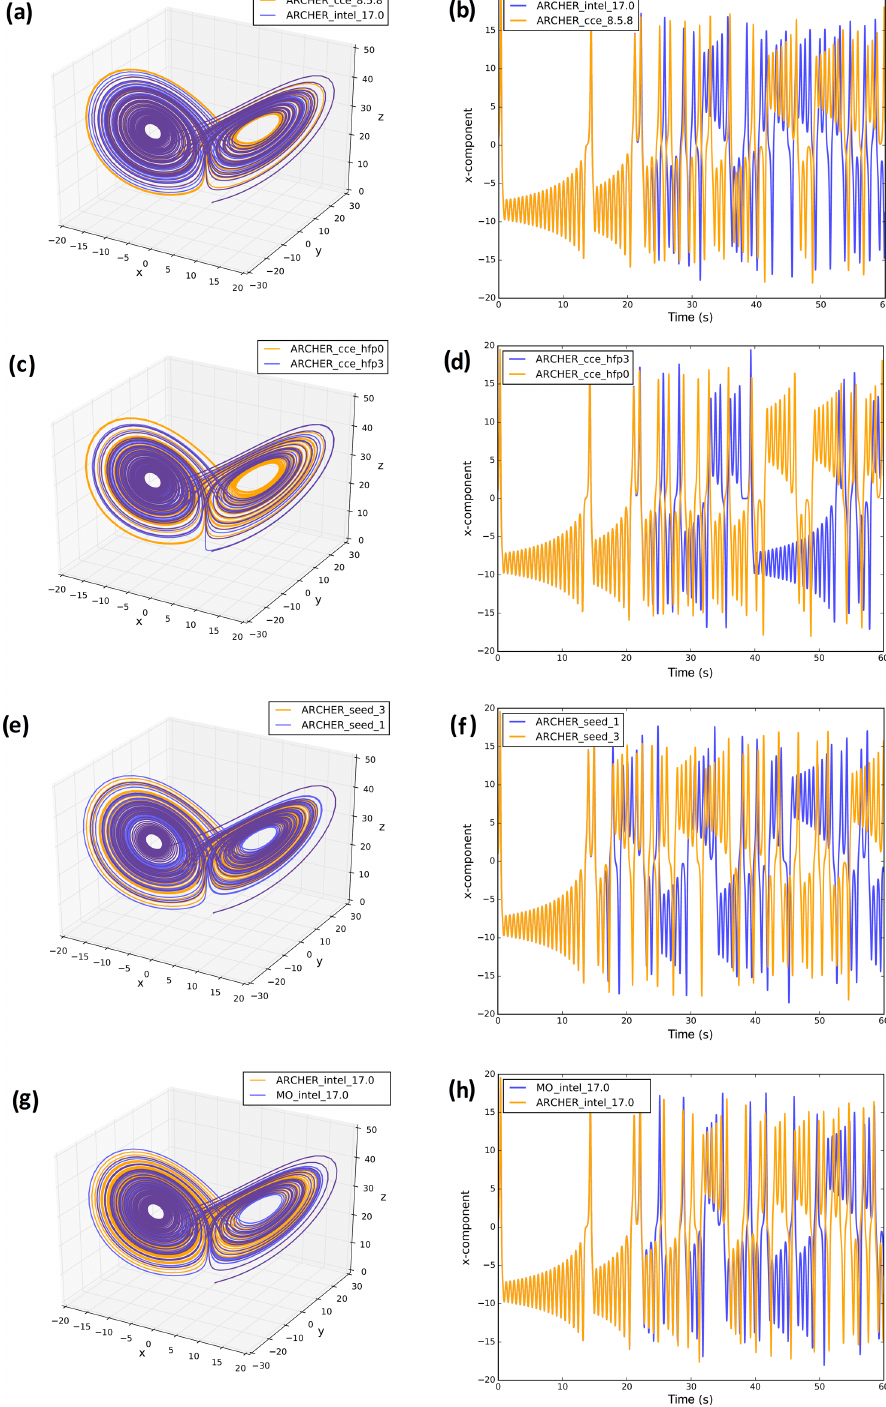
Figure 1. Attractor (left-hand side) and time series of the x component (right-hand side) of the 3-D Lorenz model for simulations run on ARCHER using the cce8.5.8 and intel17.0 compilers (a, b) , the same compiler (cce8.5.8) but a different level of floating-point optimization (hfp0, hfp3) (c, d) , and the same compiler (cce8.5.8) and compiling options but a different seed for the random number generator (seed 1, 3) (e, f) . Panels (g) and (h) are the Lorenz attractor and the x component time series for the Lorenz model run on MO and ARCHER using the same compiler (intel17.0) and compiling